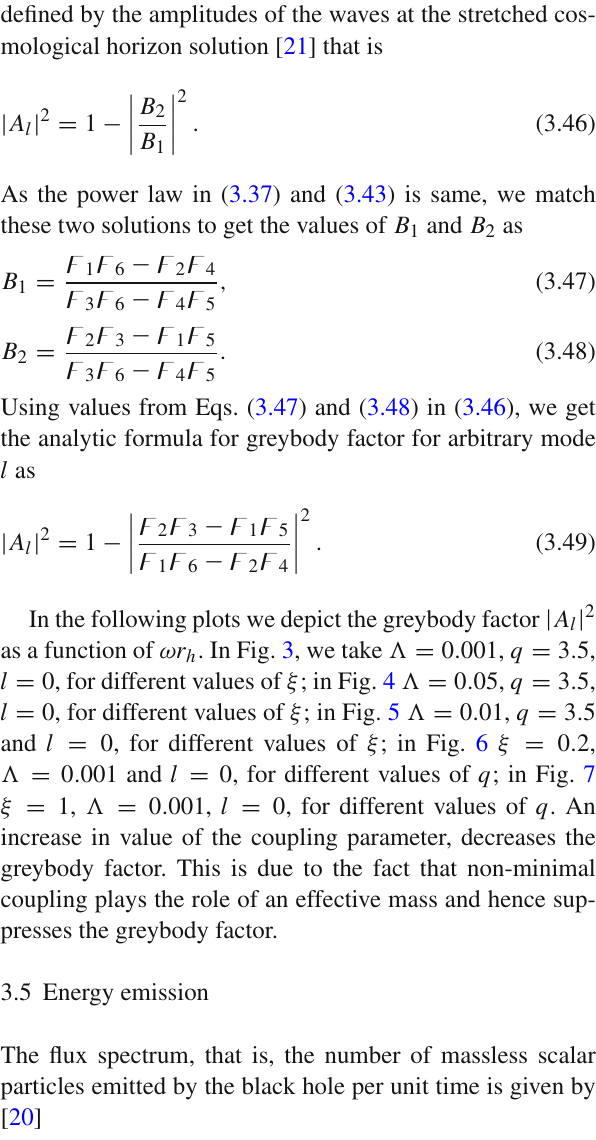
Fig. 3 Greybody factor as a function of ω r h for different values of ξ , when (cid:5) = 0 . 001, q = 3 . 5 and l = 0